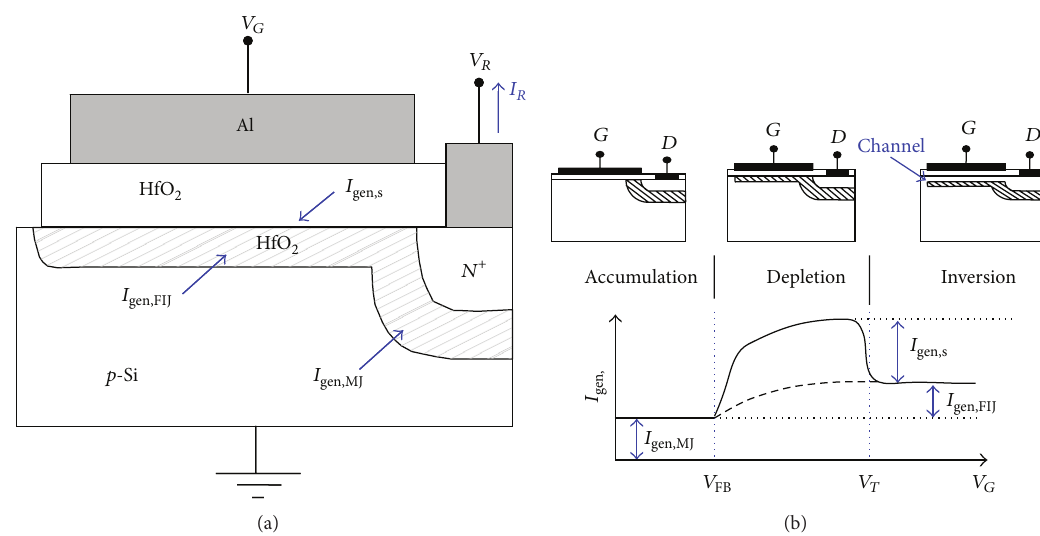
Figure 1: (a) Cross-sectional diagram of an HfO 2 gated diode. (b) Effect of the depletion region on the reverse current 𝐼 𝑅 of the gated diode at various gate voltages given a fixed reverse drain voltage 𝑉 𝑅